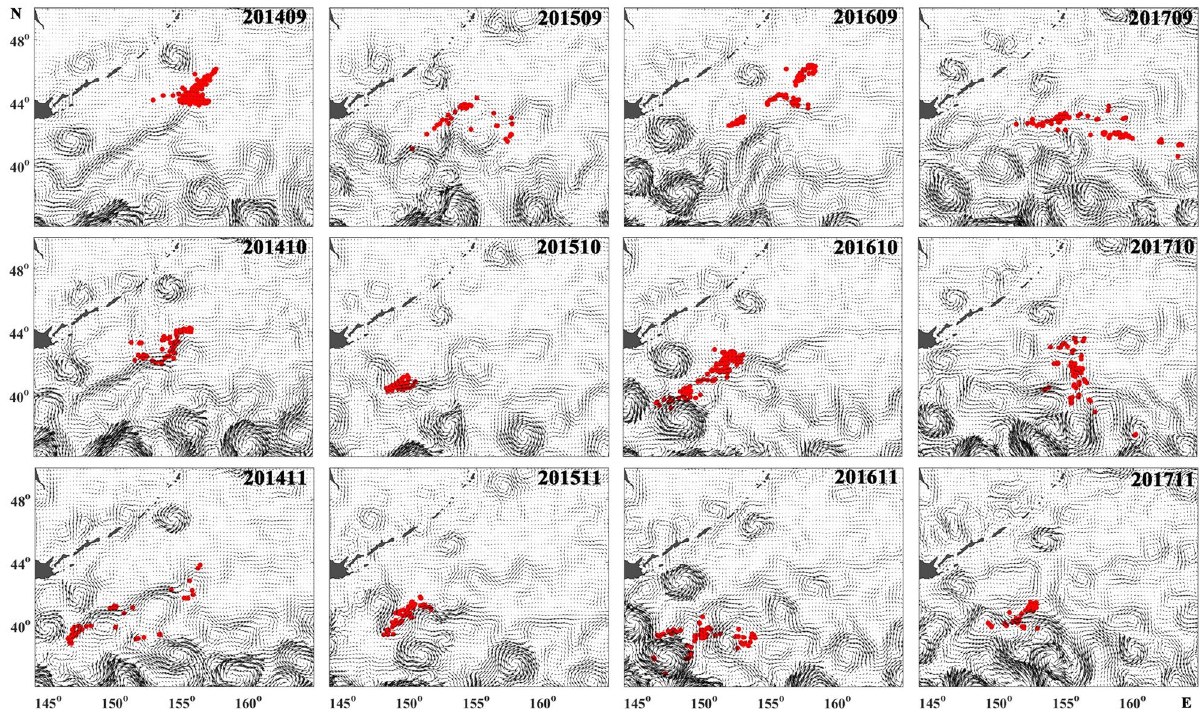
Figure 9. Spatial distribution of Pacific saury fishing locations superimposed on monthly geostrophic currents in September–November between 2014 and 2017. Fishing locations are shown as red dots. Maps were created using MATLAB R2016a sofware by MathWorks (https:// ww2. mathw orks. cn/ produ cts/ matlab. html).